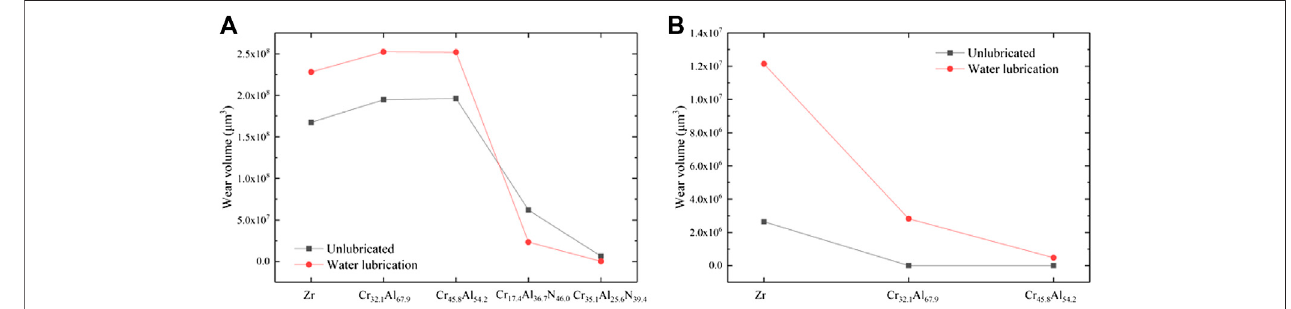
Frontiers in Energy Research |